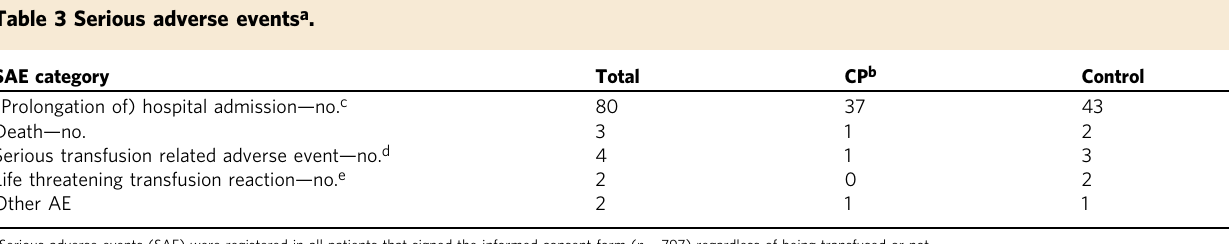
Table 3 Serious adverse events a